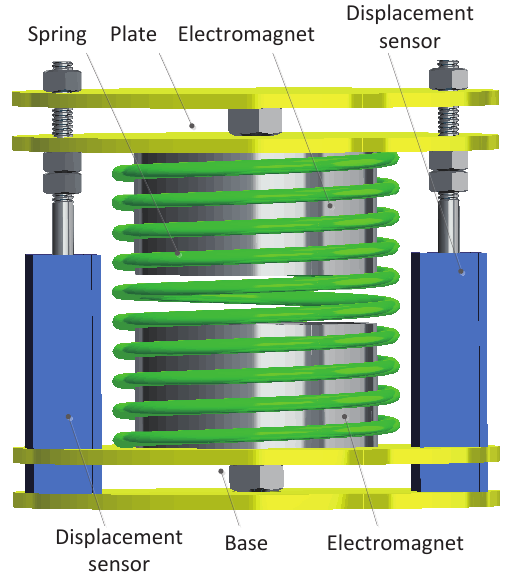
Figure 1. Structure of the electromagnetic isolation